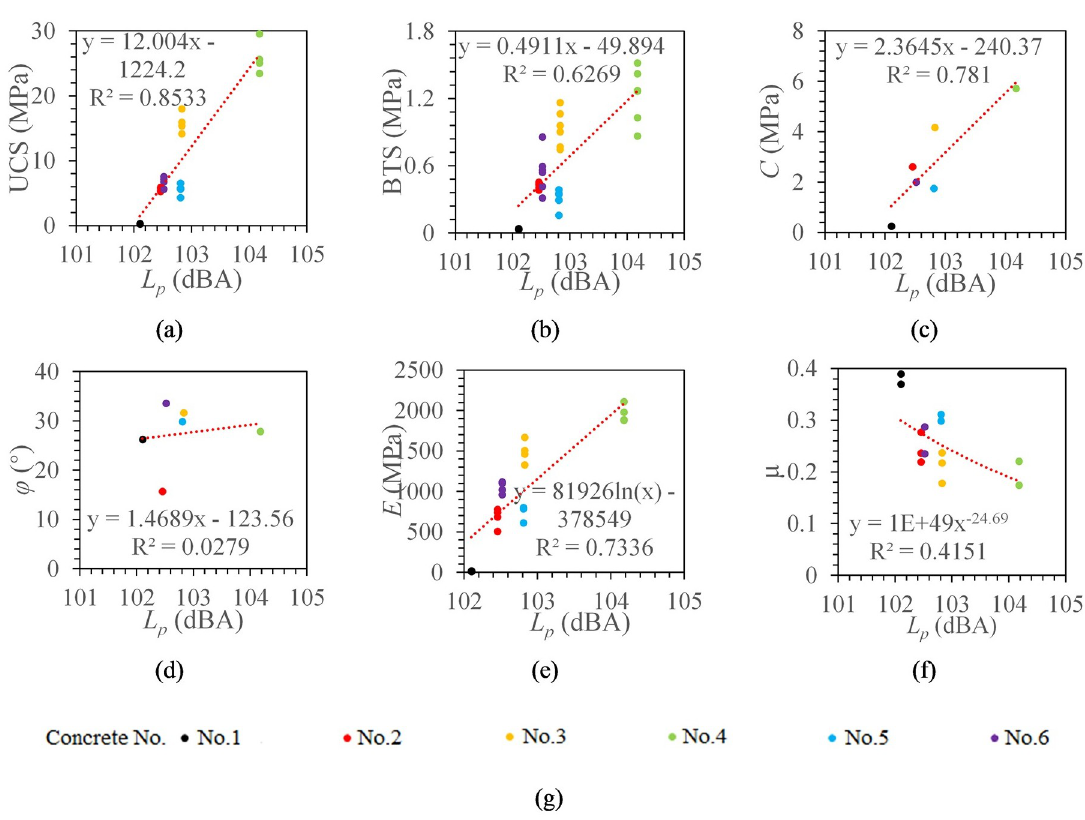
Fig 6. The relationship between SPL and concrete mechanical properties. L (b) The relationship between L p and BTS. (c)The relationship between L p and C . (d) The relationship between L p and φ . (e) The relationship between L and E . (f) The relationship between L p